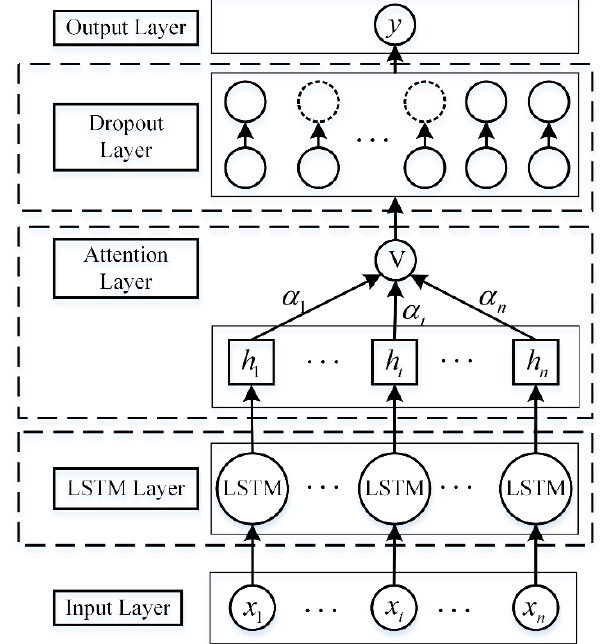
Figure 5. Improved LSTM short term forecast model of electric heating